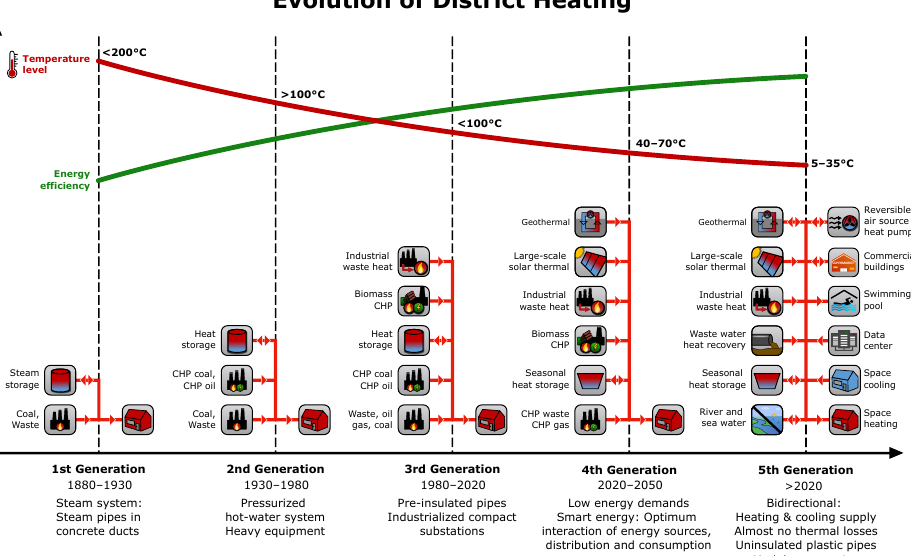
Figure 1. Visualisation of the evolution of district heating and cooling networks, from the 1st to the 5th generation of DHC networks